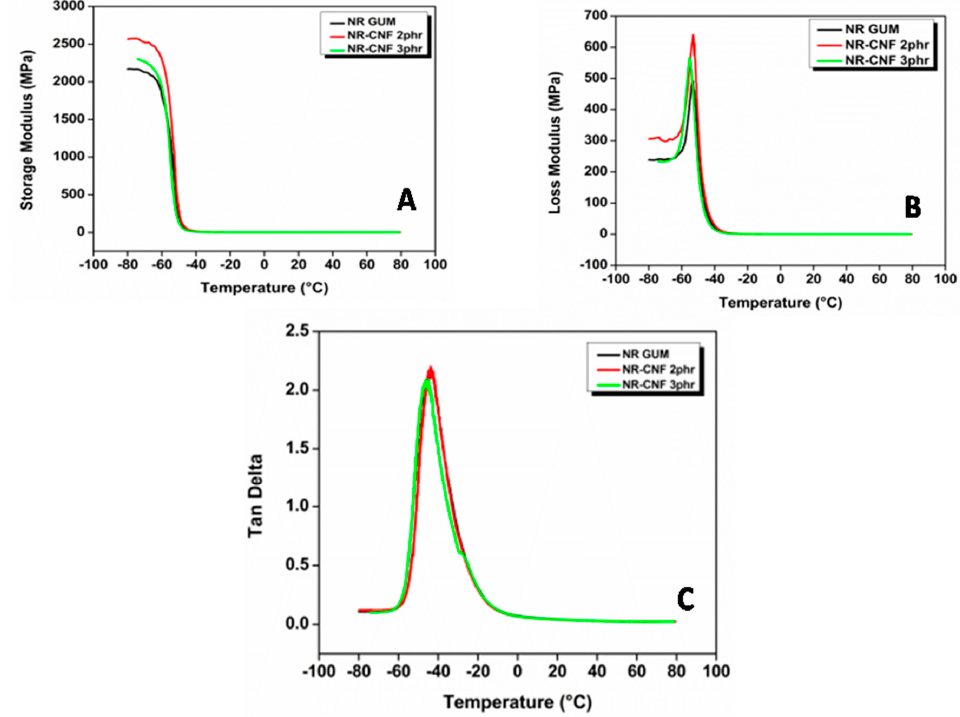
Figure 8. ( A ) Variation of storage modulus with temperature, ( B ) variation of loss modulus with temperature and ( C ) variation of loss tangent with temperature of NR–CNF nanocomposites. Table 7. Dynamic mechanical analysis data of NR gum and NR–CNF nanocomposites.